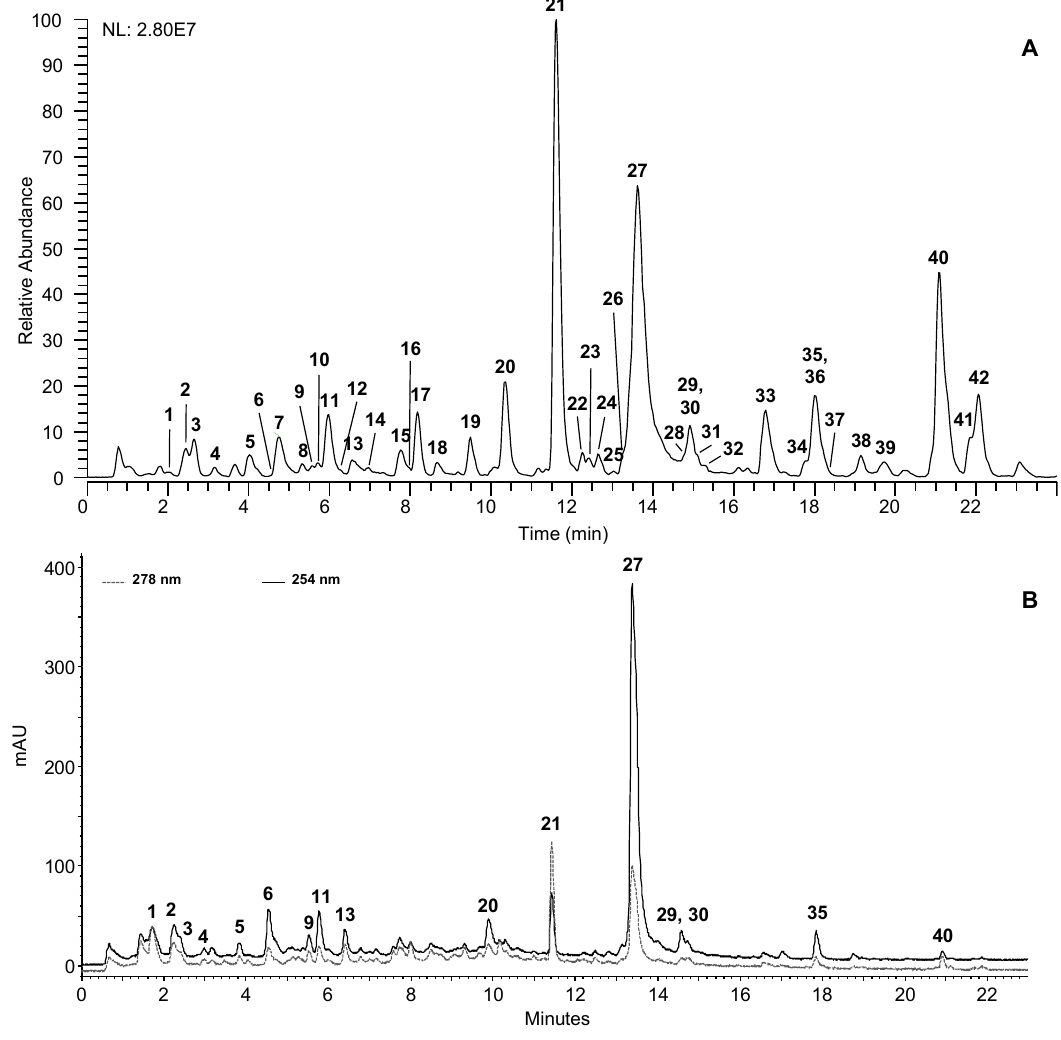
− )HRMS ( A ) and UHPLC-UV ( B ) profiles of Figure 1. UHPLC-(−)HRMS ( A ) and UHPLC-UV ( B ) profiles of CSB-M. Figure 1. UHPLC-(